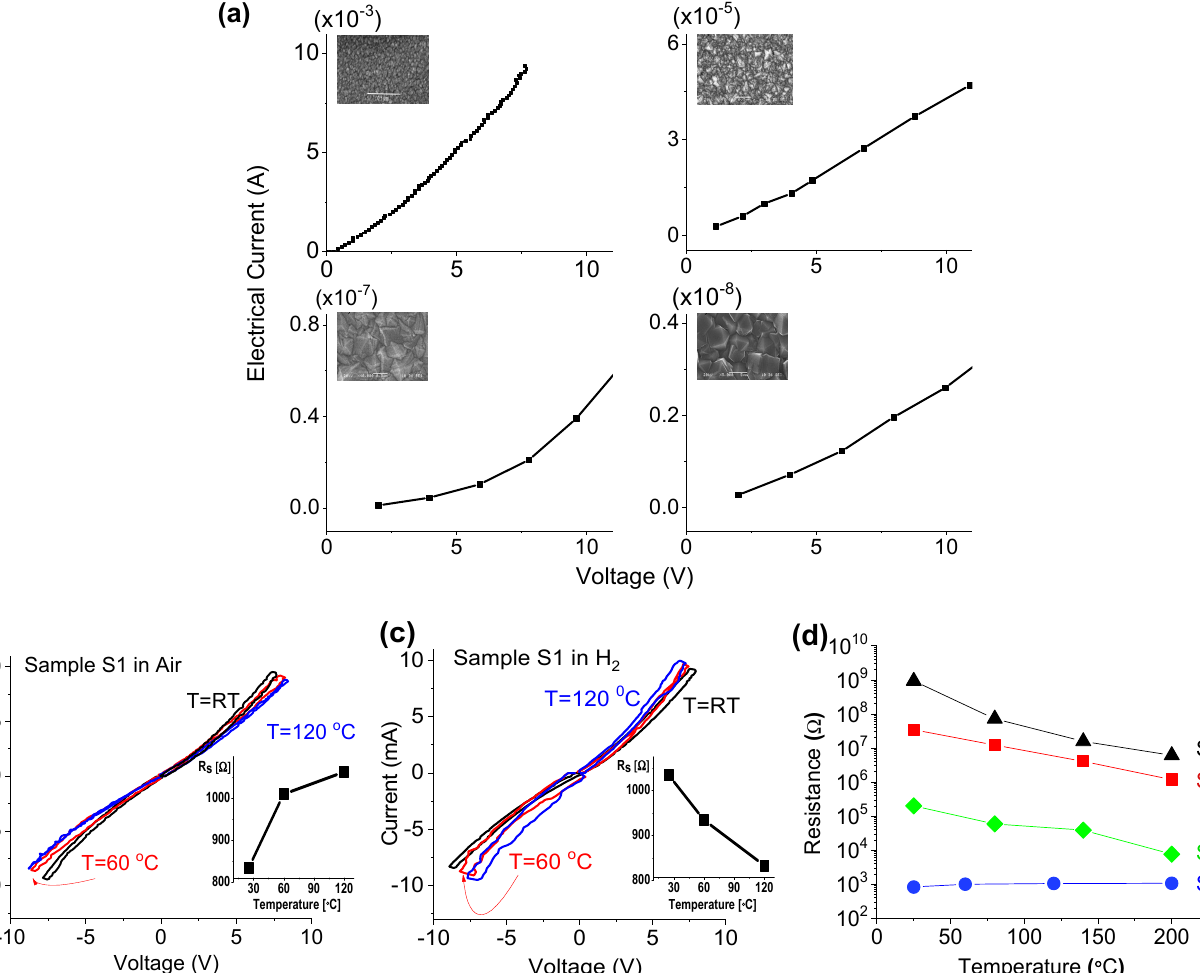
Figure 4. I–V properties of S1–S4 samples in ( a ) open air at room temperature, ( b ) open air, and ( c ) at 25 (RT), 60, and 120 ◦ C. Inset: the calculated resistances. ( d ) The measured resistances of samples H 2 at 25 (RT), 60, and 120 °C. Inset: the calculated resistances. ( d ) The measured resistances of sam- S1–S4 in open air at room temperature to 200 ◦ ples S1–S4 in open air at room temperature to 200 °C.